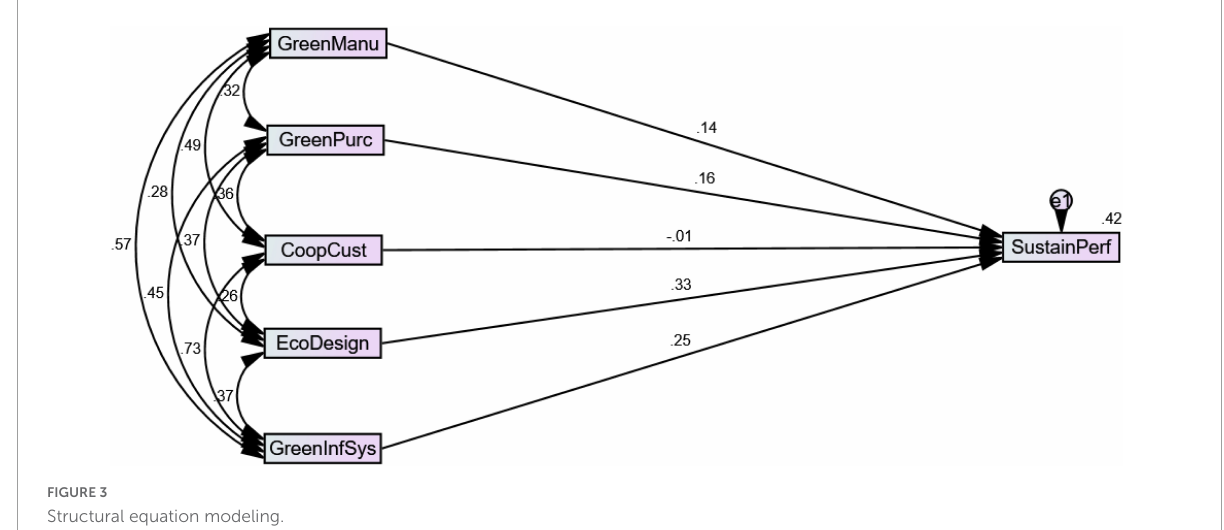
FIGURE3 Structural equation